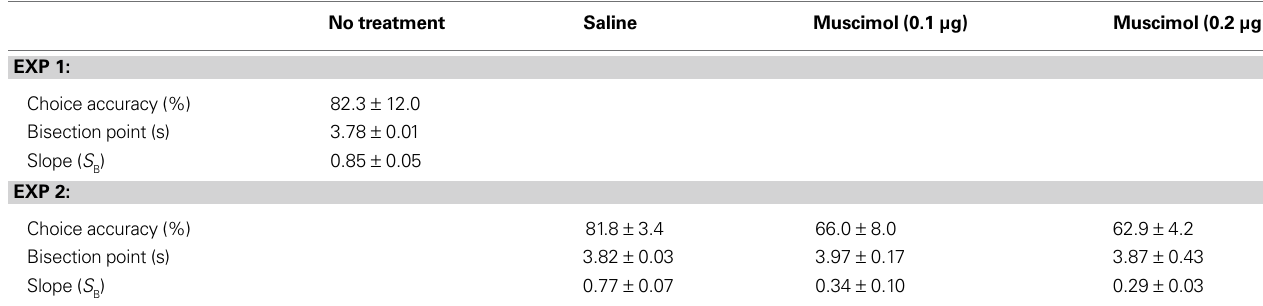
Table 1 | Animal’s performance in the random-trial task. Results are expressed as mean ± SEM ( n = 3 animals in each experiment). No